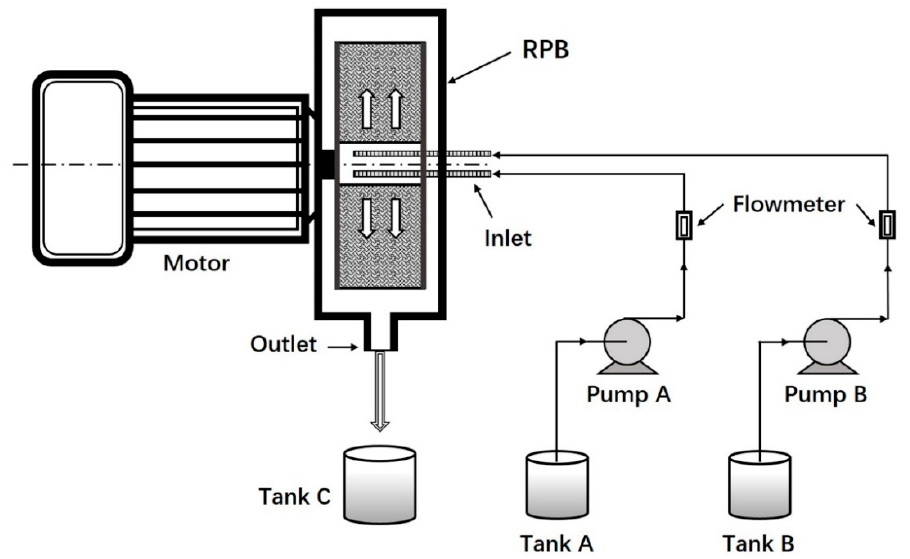
Figure 1. Schematic diagram of experimental setup.